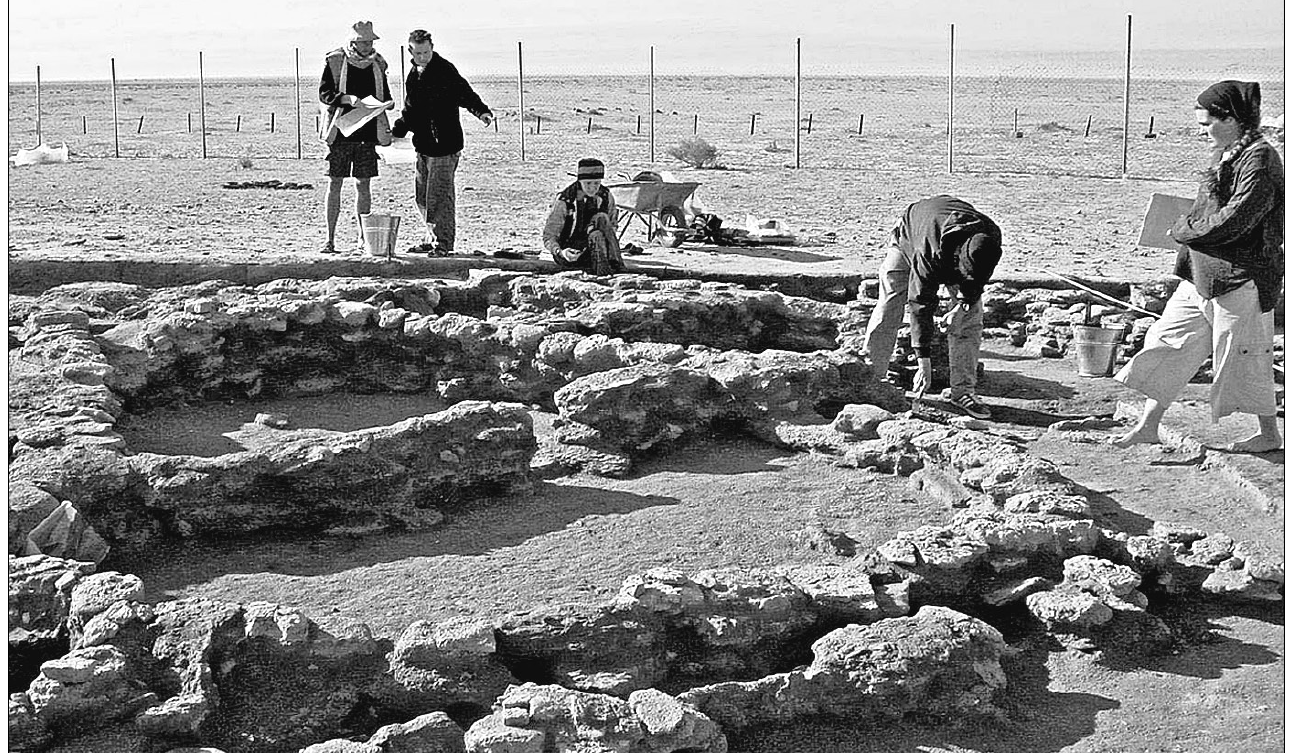
Figure 2 The Neolithic site of H3, showing chambers within one of the stone-built structures.